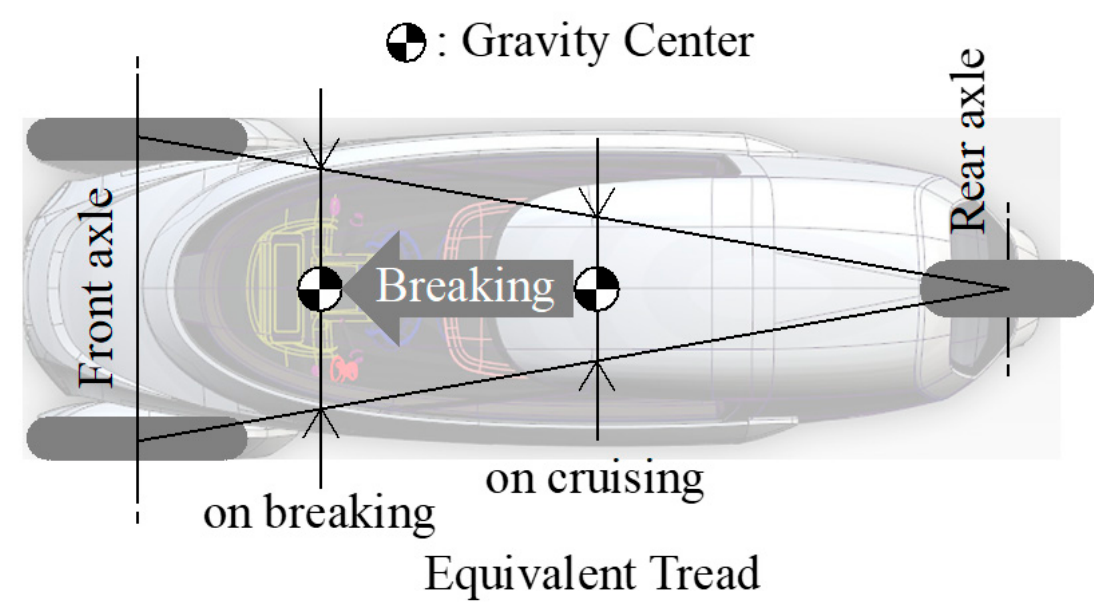
Figure 1. Equivalent tread is wider on breaking. Table 1. Advantages ( (cid:52) ) / Disadvantages ( (cid:72) ) of di ff erent types of personal mobility vehicles (PMVs). Simple